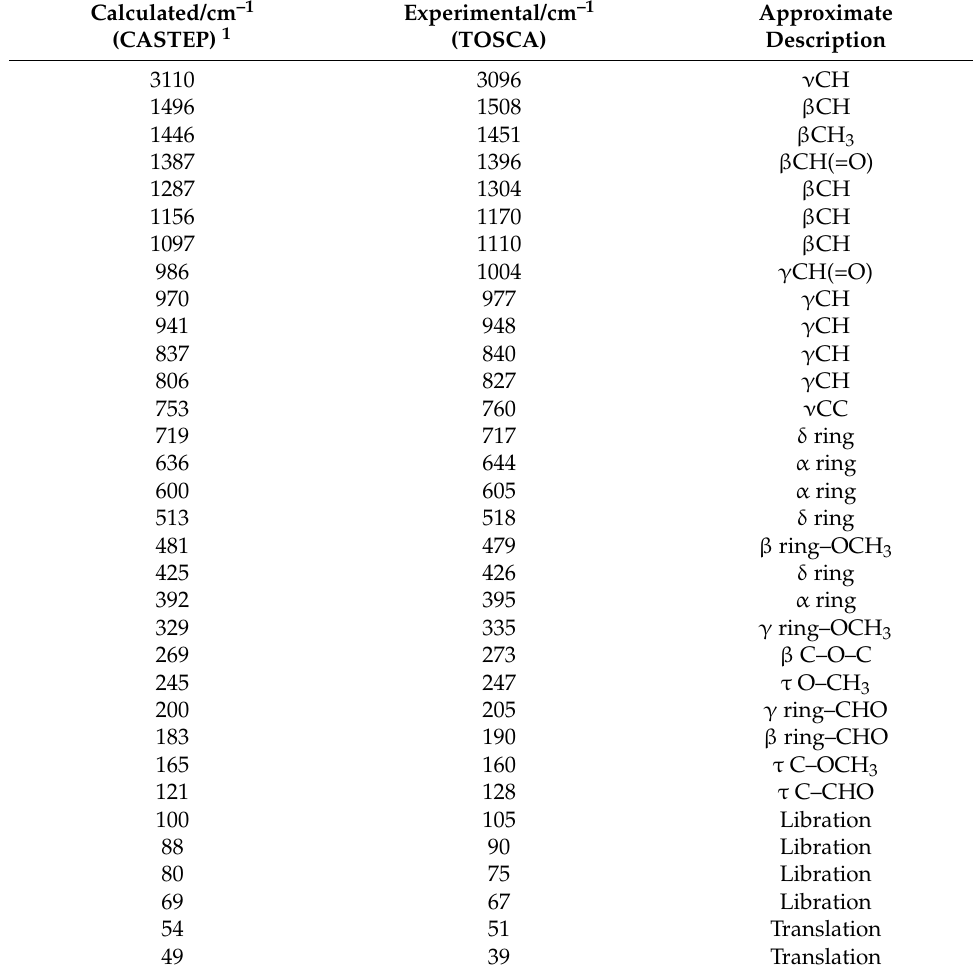
Table 4. Experimental and calculated INS maxima for 4MeOB with mode